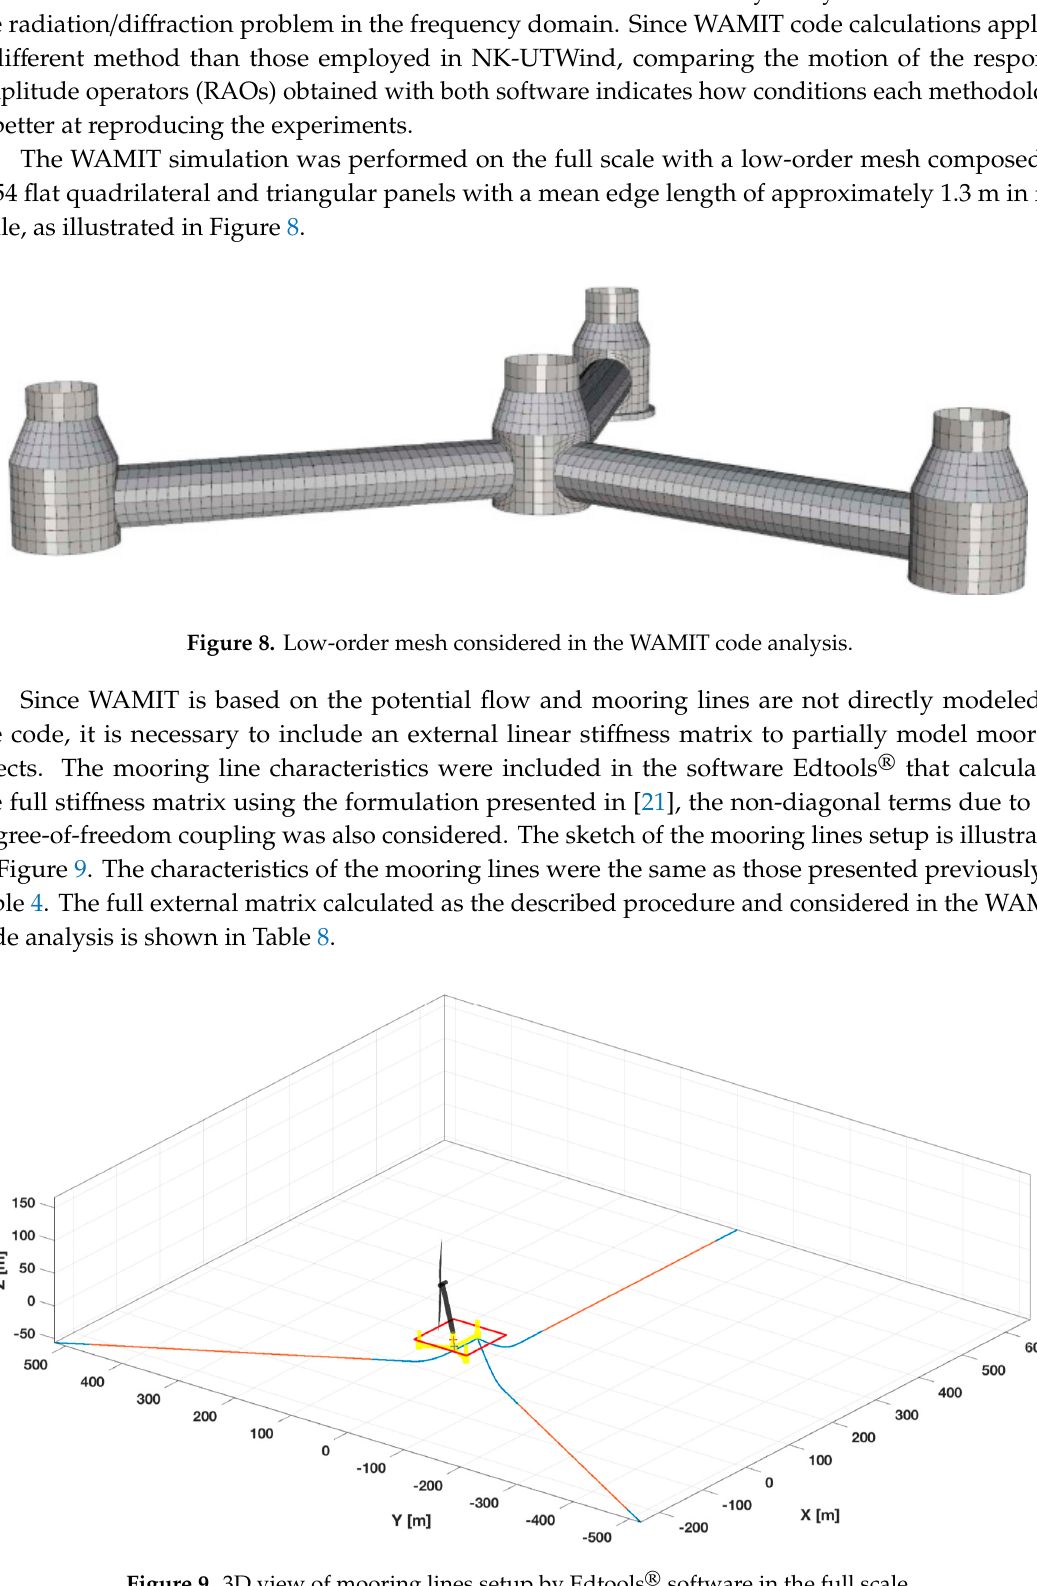
Figure 9. 3D view of mooring lines setup by Edtools ® software in the full scale.